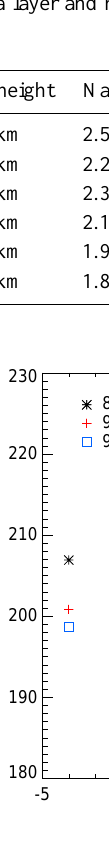
Fig. 6. Time series of temperature at 85km (black asterisks), 91km (red plus signs) and 97km altitude (blue squares) measured with the ALOMAR Na lidar. The temperature values are the mean values of each day from both lidar beams. Dates are given as day of December, i.e. “ − 4” corresponds to 26 November 2010.